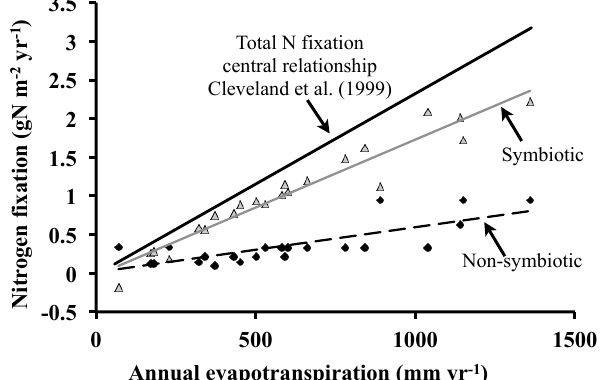
Table A2. Mean simulated preindustrial nitrogen